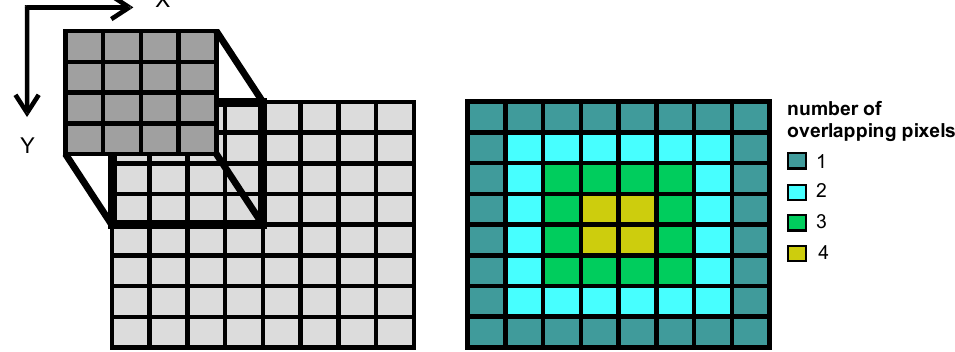
Figure 5. Edge effect caused by window classification. The number of pixels at the edges of the large image is less than the center due to the smaller overlapping range.